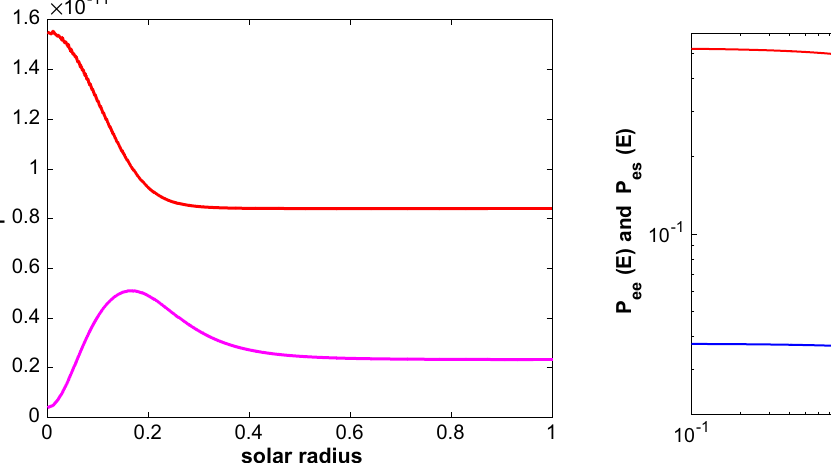
Fig. 3 The neutrino probability functions: P es ( E ) corresponds to the probability of conversion of ν e to ν s neutrinos given by Eq. (2) (bottom set of curves); and P ee ( E ) corresponds to the survival probability of ν e given by Eq. (3) (top set of curves). The red, green and blue curves correspond to neutrinos with energy of 0.1, 5 and 15 MeV, which corre- spond to typical values of neutrino energies produced inside the Sun’s core. In the computation of these quantities we used the standard solar model (see Lopes and Silk [30] for details)